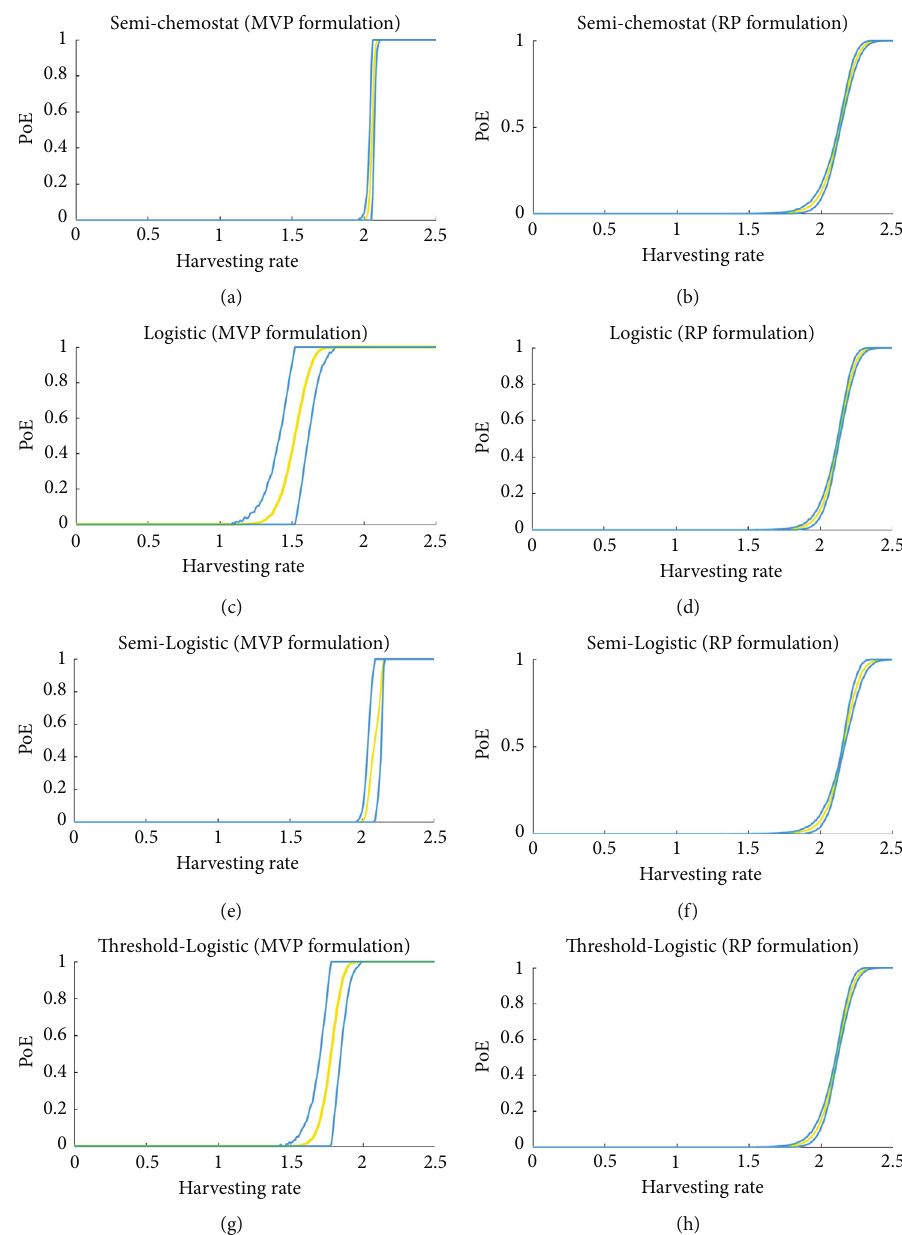
Figure 7: Probability of extinction (PoE) with respect to the harvesting rate is calculated by using the algorithm described in Appendix B.3. The yellow curve (a, c, e, g) shows the mean of the MVP formulation of the probability of extinction, and the light blue curves represent the interval of three standard deviation (68%) of this probability of extinction. For the RP formulation of the probability of extinction (b, d, f, h), the mean is shown by the yellow curve and the three standard deviations by the light blue